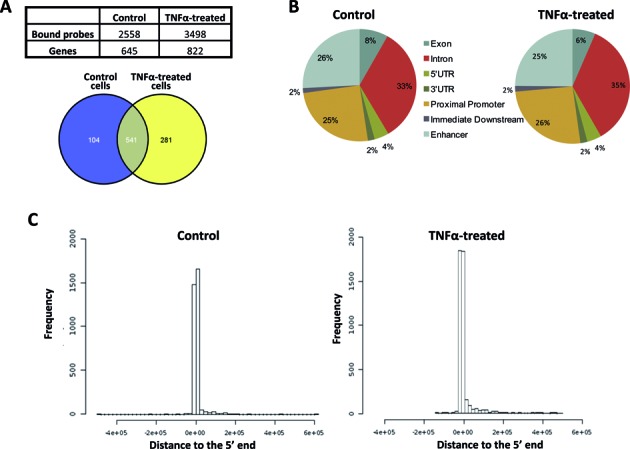
Analysis of SND1 binding regions. HepG2 cells were treated with TNFα (50 ng/ml, 24 h) or left untreated (control) before performing ChIP-chip analysis for SND1 binding. (A) Bound probes and Venn diagrams of the corresponding genes. (B) Identification of the genomic location of SND1 binding regions using PinkThing. (C) Positional distribution of the identified SND1 binding regions relative to the 5′ end in control and TNFα-treated cells. Graphs (B and C) are representative of three experiments with similar results.